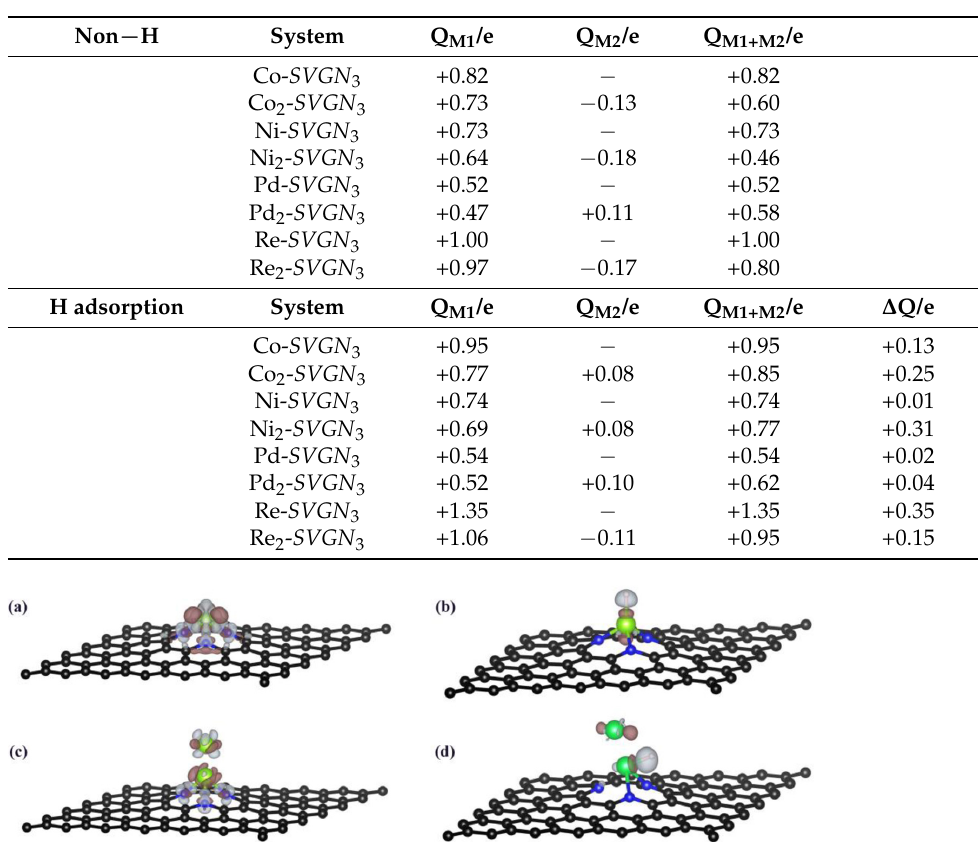
Table 4. Bader Charges, Q(e), of the typical TMs in SACs and DACs with non − H and H adsorption. (“+” means electron loss; “ − ” means electron gain).